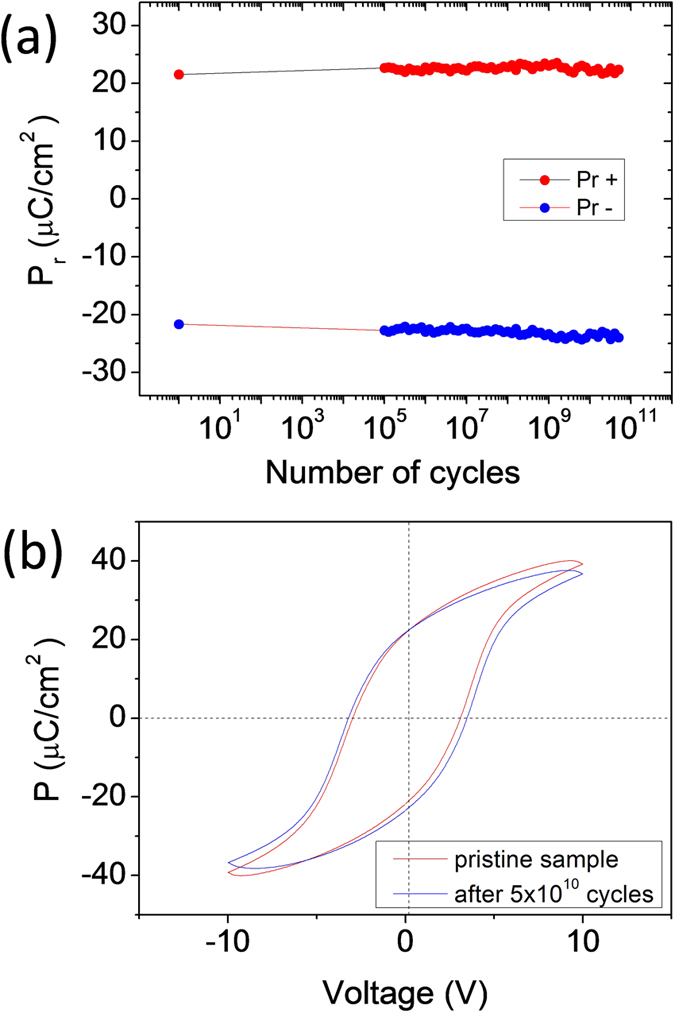
Ferroelectric endurance.(a) Polarization fatigue as a function of the number of cycles measured at room temperature in a tCFO = 50 nm sample. (b) Polarization – voltage loops of the pristine sample and after 5 × 1010 cycles.